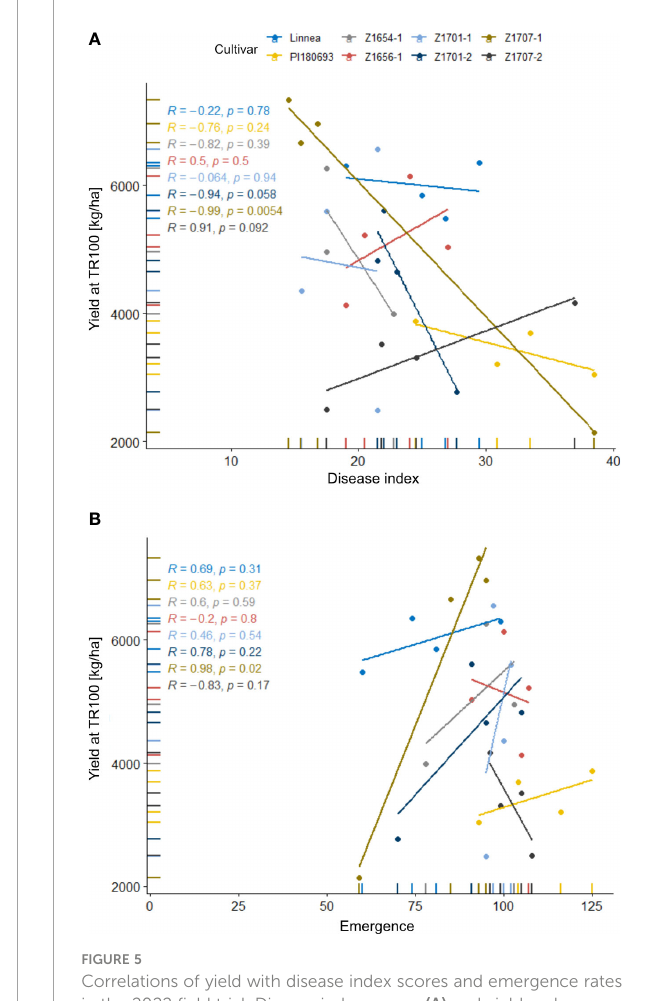
FIGURE 5 Correlations of yield with disease index scores and emergence rates in the 2022 fi eld trial. Disease index scores (A) and yield and emergence rates (B) in fi eld R-22-10-91are averages of four replicates per cultivar. Disease index is measured on a scale from 0 (completely healthy plant) to 100 (completely diseased) and emergence levels indicate the number of emerged plants per square meter. Lines represent linear regressions between the two factors, R values show Pearson correlation coef fi